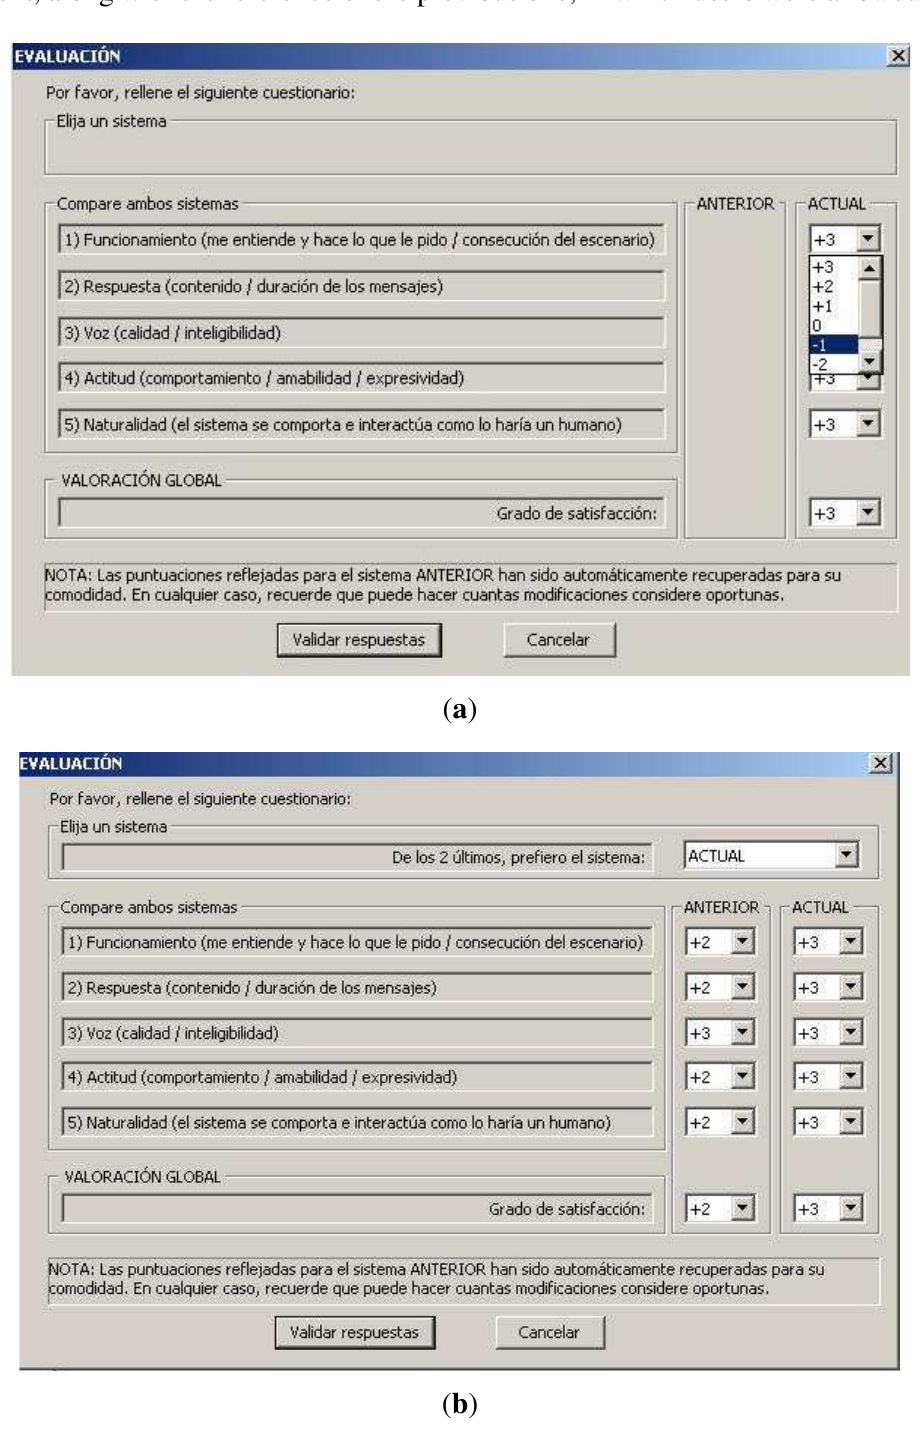
Figure 4. The virtual questionnaires. ( a ) Ratings for the current agent; ( b ) ratings for the next agent, along with the reference of the previous one, in which users were allowed to